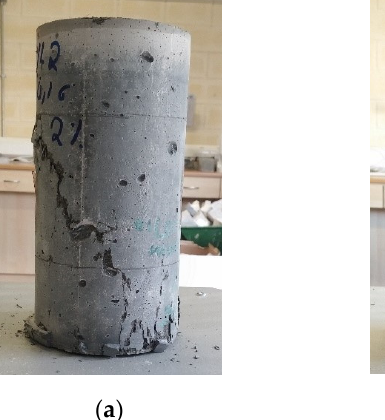
Figure 12. Failure of UHPFRC mixtures ( a ) 2(0-2)/16/6.1, ( b ) 6(5-1)/16/6.1, and ( c ) 6(3-3)/16/6.1.